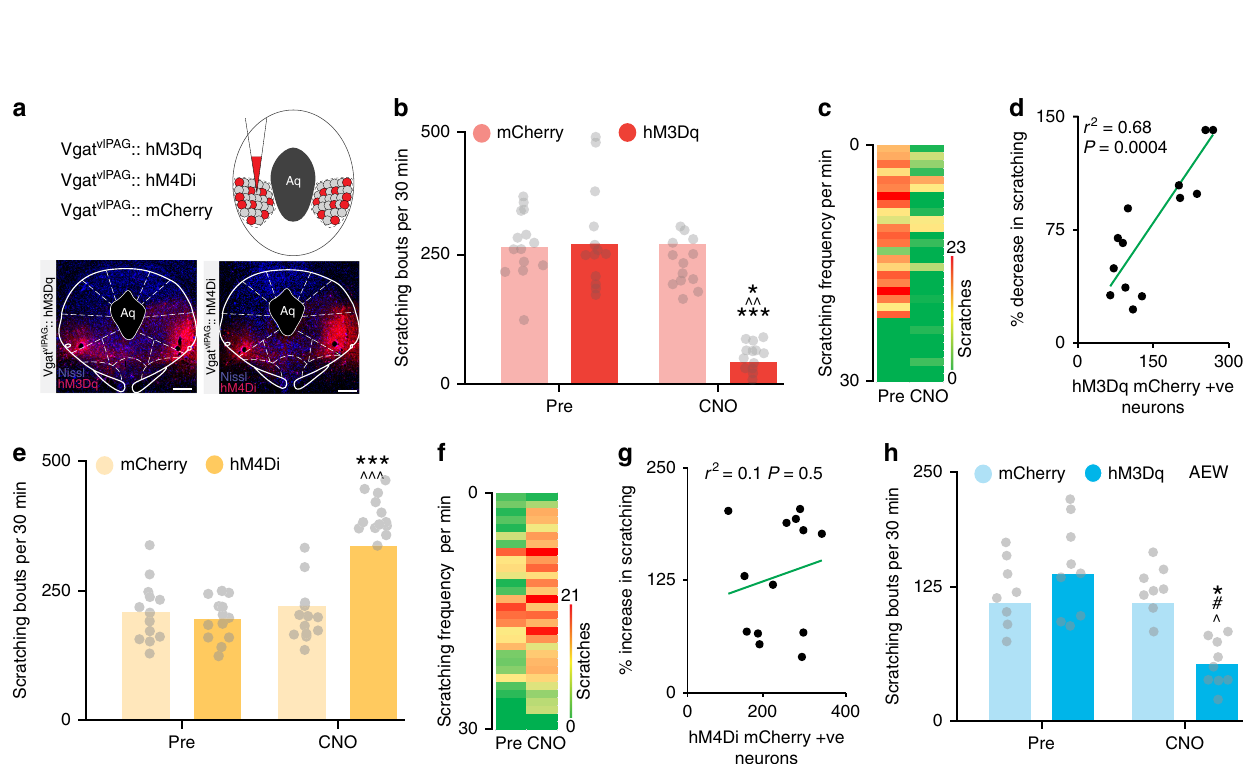
Fig. 5 vlPAG GABAergic neuronal activity modulates sensory component of itch. a Viral targeting of AAV5-hSyn-DIO-hM3Dq – mCherry, AAV5-hSyn-DIO- hM4Di – mCherry and AAV5-hSyn-DIO-mCherry bilaterally into the vlPAG of Vgat Cre mice. Representative vlPAG sections showing restricted viral expression of hM3Dq – mCherry and hM4Di – mCherry in the vlPAG of Vgat Cre mice. b CNO (5 mg/kg, i.p) had no signi fi cant effect on chloroquine evoked scratching in Vgat Cre mice expressing the control mCherry construct in the vlPAG. However, CNO (5 mg/kg, i.p) administration resulted in signi fi cant reduction in chloroquine evoked scratching in mice that express hM3Dq in the vlPAG of Vgat Cre mice. Interaction; F (1, 24) = 21.14, ^^ P < 0.001. Pre vs. CNO; F (1, 24) = 7.531, * P = 0.0113. mCherry vs. hM3Dq; F (1, 24) = 39.20, *** P < 0.0001. N = 13/group. Two-way ANOVA. c Heat map showing averaged chloroquine-evoked scratching bouts pre-CNO and post-CNO. d Chloroquine evoked scratching in hM3Dq injected mice after CNO administration is directly correlated with number of hM3Dq-mCherry + neurons. R 2 = 0.68, P = 0.0004. e Inhibition of vlPAG neurons by CNO (5 mg/kg, i.p) administration resulted in a signi fi cant increase in chloroquine evoked scratching in Vgat::hM4Di mice compared to baselines while control mCherry injected mice in the vlPAG show no difference in chloroquine evoked scratching after CNO (5 mg/kg, i.p) administration. Interaction; F (1, 24) = 32.55, ^^^ P < 0.0001. Pre vs. CNO; F (1, 24) = 27.60, ### P < 0.0001. mCherry vs. hM4Di; F (1, 24) = 40.65, *** P < 0.0001. N = 13/group. Two-way ANOVA. f Heat map showing averaged chloroquine-evoked scratching bouts pre-CNO and post-CNO in mice expressing hM4Di. g Chloroquine evoked scratching in hM4Di injected mice after CNO administration is not correlated with number of hM4Di-mCherry + vlPAG in the Vgat Cre mice. R 2 = 0.1, P = 0.5. h Activation of vlPAG GABAergic neurons with CNO (5 mg/kg, i.p.) resulted in a signi fi cant reduction of spontaneous scratching behavior produced by AEW treatment. CNO administration did not affect spontaneous scratching behavior produced by AEW treatment in control mCherry injected mice. Interaction; F (1, 14) = 9.056, *** P = 0.0094. Pre vs. CNO; F (1, 14) = 13.58, ^^ P = 0.0024. N = 8/group. Two-way ANOVA. All values are mean ± SEM. Source data are available as